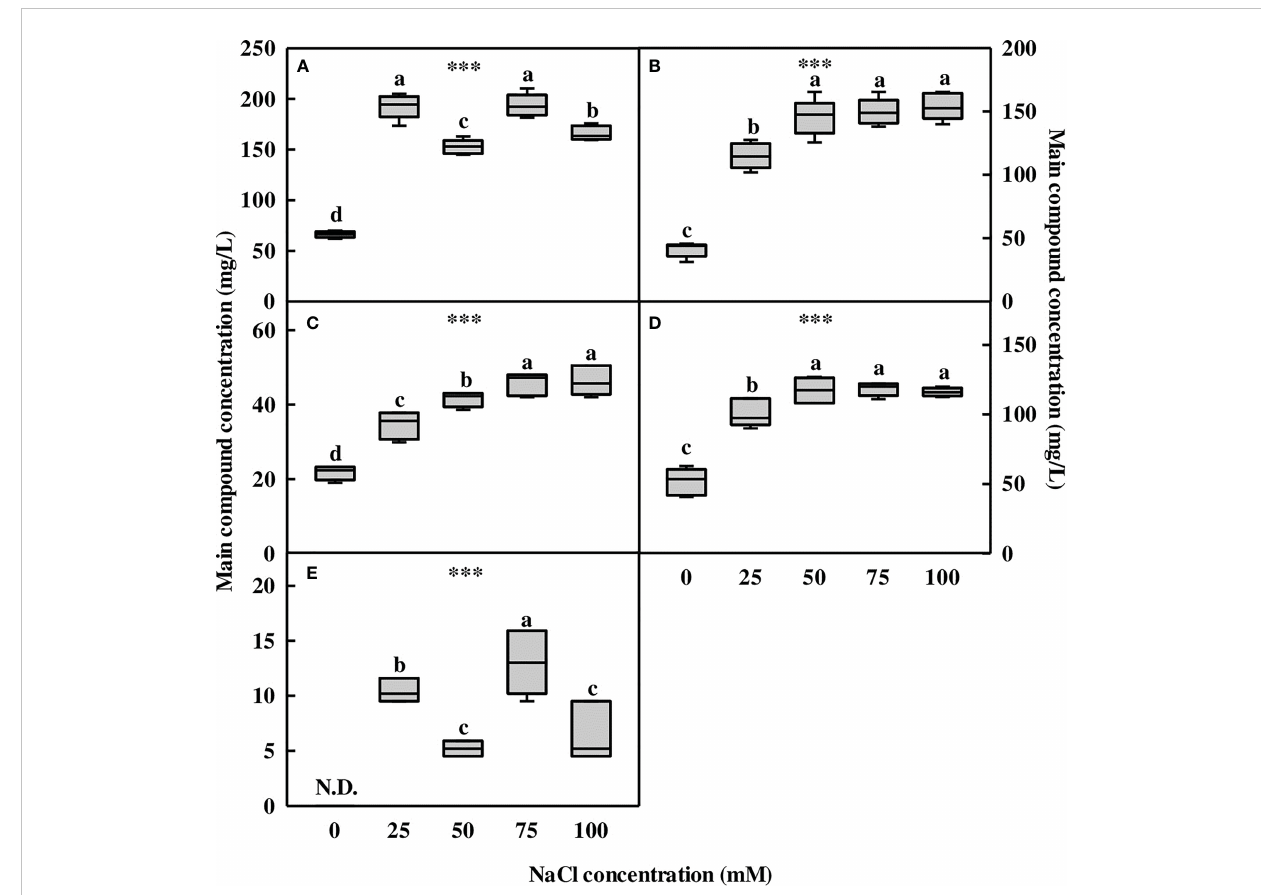
FIGURE 3 The concentration of the major compounds of Limonium tetragonum under different NaCl concentrations analyzed using LC-ESI-MS ( n = 5). (A) Compound 1 (myricetin-3-O- b -D-galactoside), (B) compound 2 , (C) compound 3 , (D) compound 4 , and (E) compound 5 . Statistical analysis was performed with Duncan ’ s multiple range test. *** p = 0.001. N.D.,